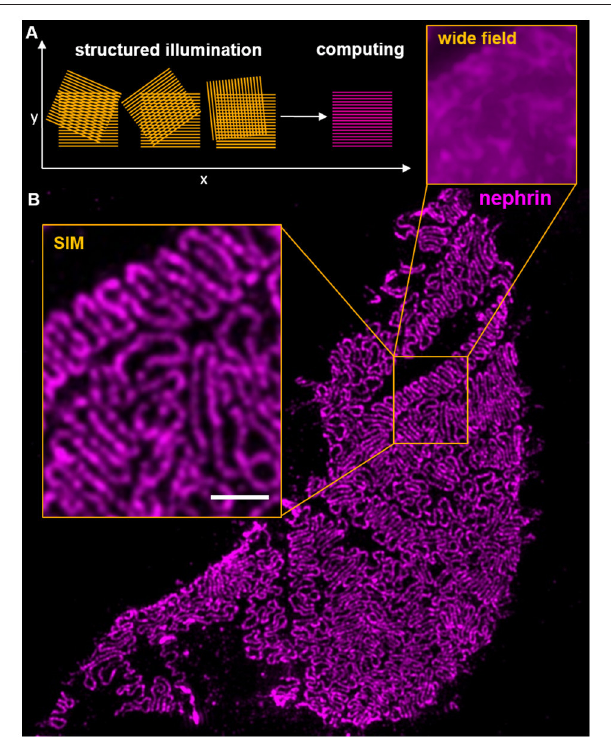
FIGURE 2 | The scheme in (A) shows the interference of an illumination pattern in three different angles with the probe. In the first phase, vertical Moiré patterns are clearly visible and resolvable by widefield microscopy. (B) shows a histological section of a murine glomerular capillary stained for nephrin. The inserts show the gain of resolution compared from widefield microscopy and 3D-SIM. Clearly, individual interdigitating foot processes are resolvable on the glomerular capillary. The scale bar indicates 1 µ